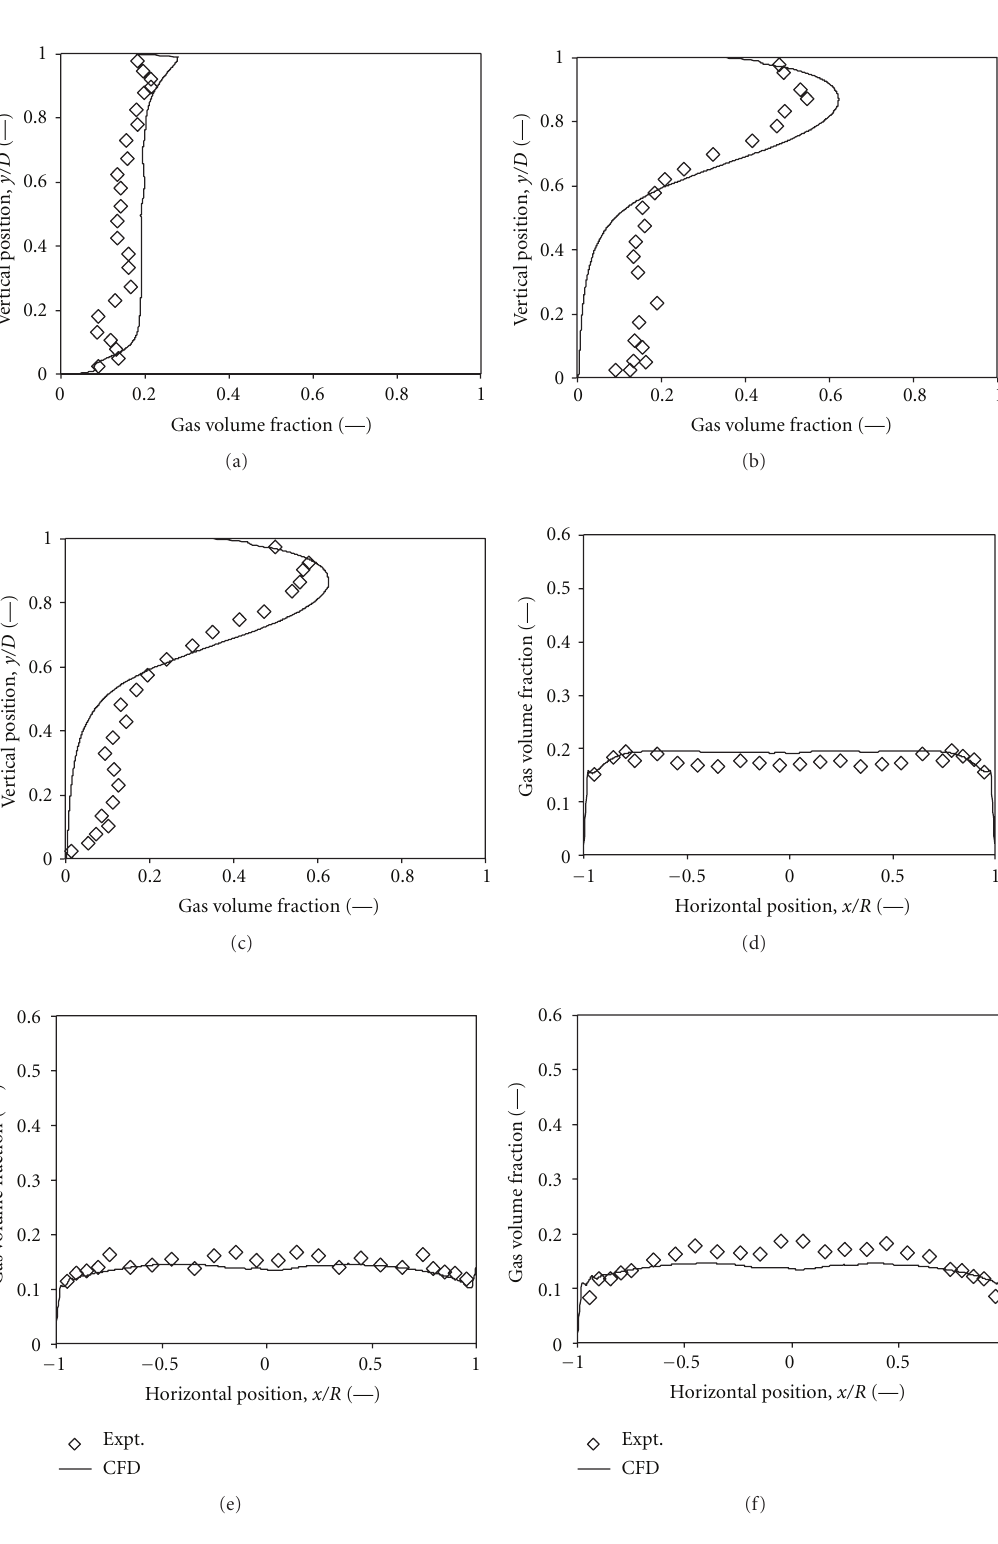
Figure 12: Gas volume fraction development in axial direction for superficial gas velocity is 1.21 m/s, superficial liquid velocity is 4.67 m/s, and average volume fraction is 0.205. At vertical position, (a) L/D = 25; (b) L/D = 148; (c) L/D = 253, at horizontal position, (d) L/D = 25; (e) L/D = 148; (f) L/D =